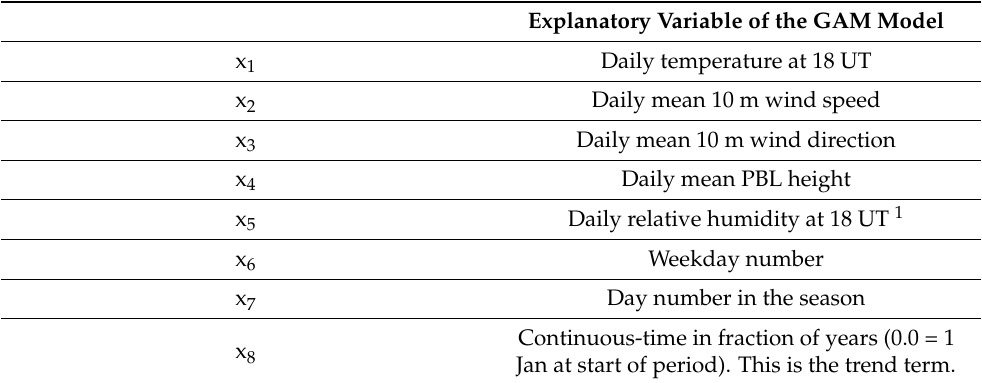
Table 1. List of input data used for the generalised additive model (GAM) calculations.